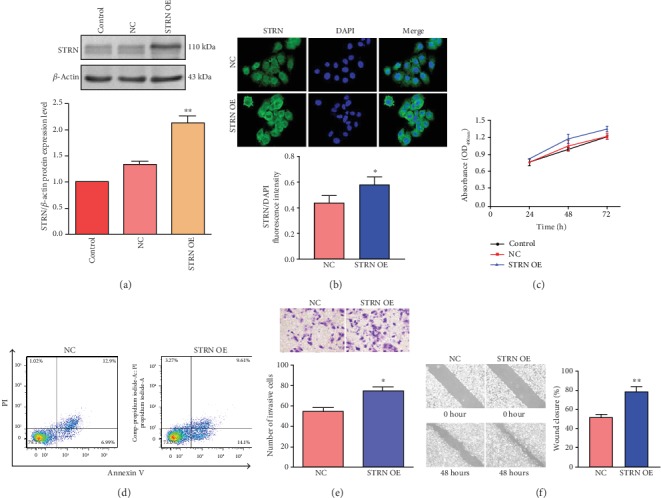
Effect of STRN overexpression on the proliferation, apoptosis, invasion, and migration capacities of Huh7 cells. (a) Western blot analysis was performed to confirm the overexpression of STRN in Huh7 cells following transfection with pcDNA3.1/hSTRN. (b) Enhanced STRN expression in Huh7 cells transfected with STRN cDNA was confirmed by immunofluorescence assay (original magnification, ×200). (c) Cell proliferation potential was measured by MTT assay in Huh7 cells transfected with STRN cDNA. (d) Cell apoptosis was assessed using flow cytometric analysis in STRN-upregulated Huh7 cells. (e) Transwell invasion assay was conducted to measure the invasive capacity of Huh7 cells overexpressing STRN, and representative bright-field microscopy images are shown (original magnification, ×200). (f) Wound healing assay was performed to investigate the migratory potential of STRN-overexpressed Huh7 cells (original magnification, ×100). ∗P < 0.05 and ∗∗P < 0.01vs. NC. Abbreviations: NC: negative control; OE: overexpression.